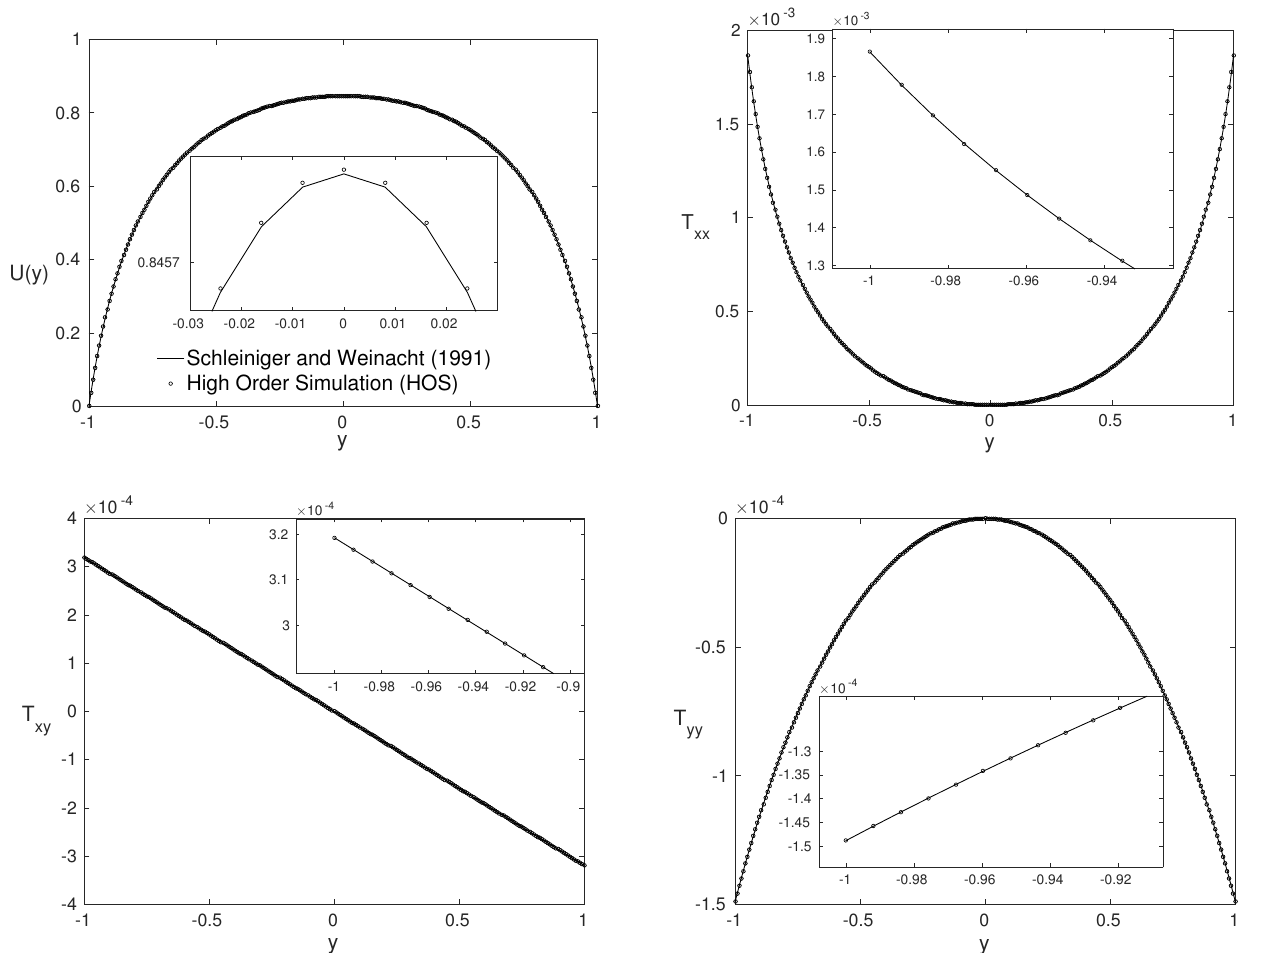
Figure 4. Same as in Figure 1 for dimensionless numbers: Re = 2000, β = 0, α G = 0.3 and Wi =